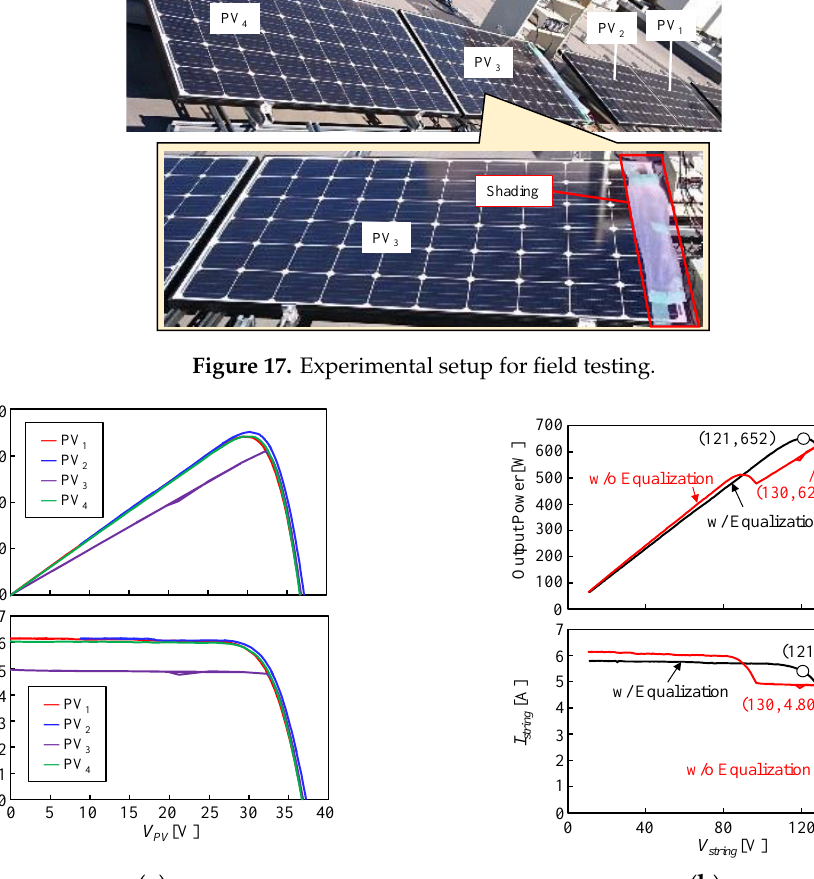
Figure 17. Experimental setup for field testing.